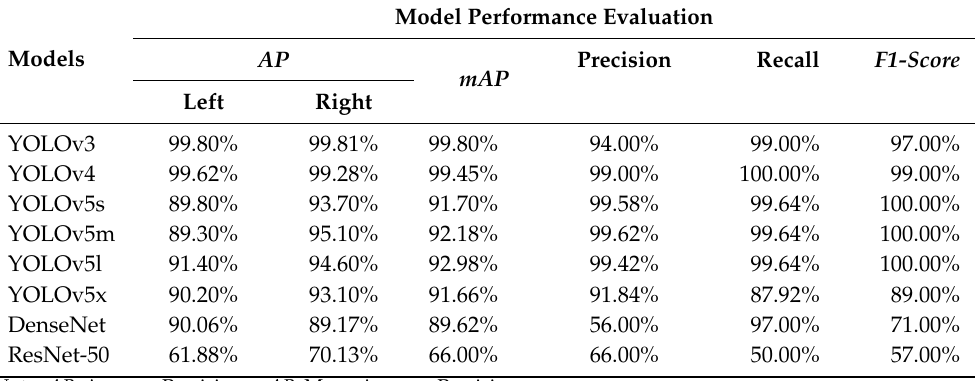
Table 1. Performance evaluation of object detection models.